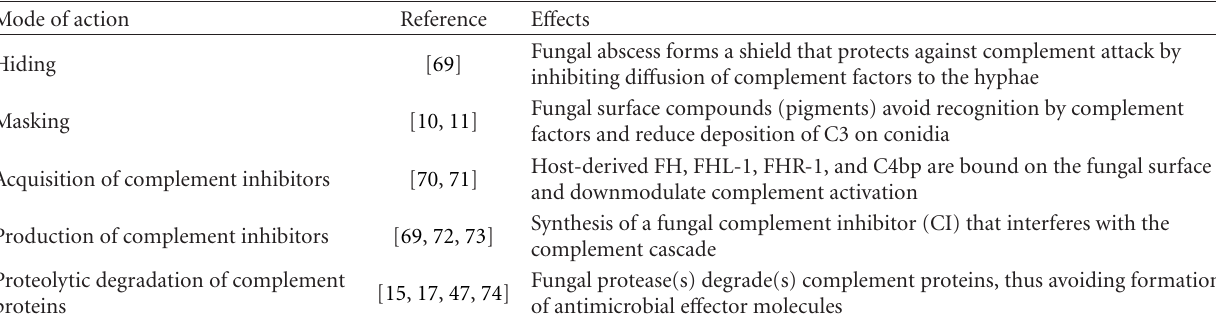
Table 1: Overview on how Aspergillus copes with the complement